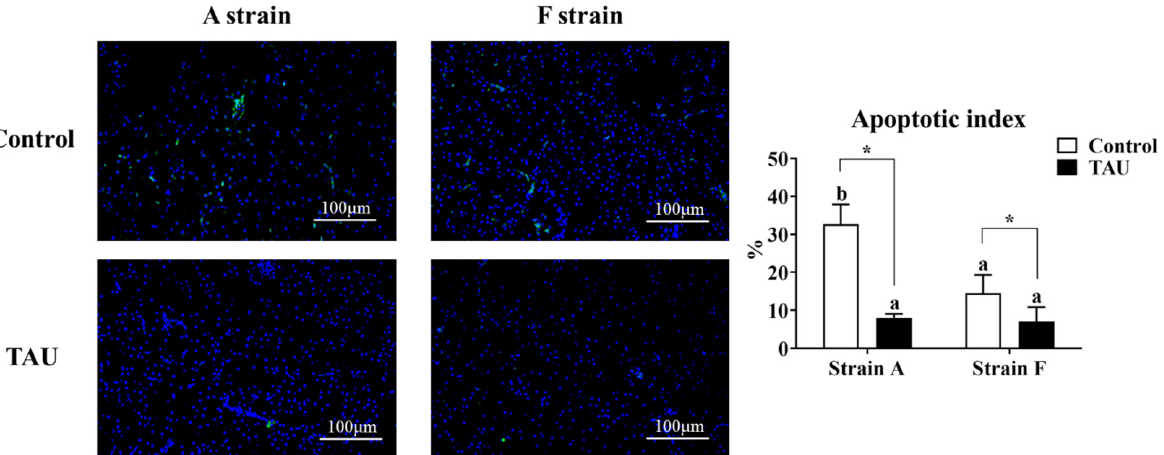
Figure 4. Representative DAPI and TUNEL double staining and image quantification results from the livers of gibel carp (A and F strains) after 96 h cadmium exposure. Positive apoptotic cells appear in green, and normal nuclei appear in blue. Control: control diet, white bars; TAU: diet supplemented with taurine, black bars. Bars with different lowercase letters (a, b) indicate the interaction effect and represent significant differences among groups ( p < 0.05). Bars with * indicate significant changes between diets in the same strain ( p < 0.05). The magnification factor is 200 × , and the scale bar is 100 μ m.